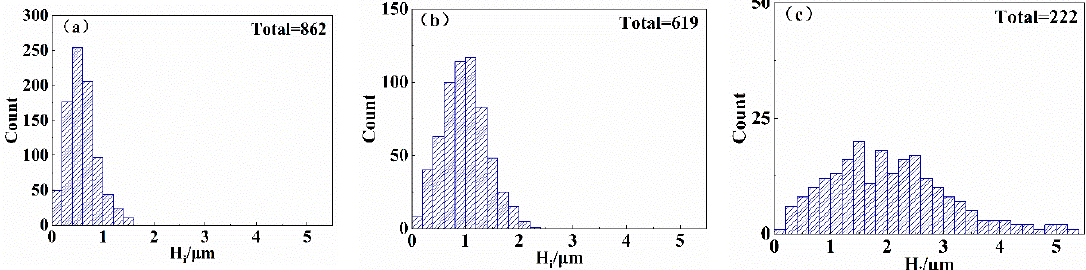
Figure 2. Histogram of height distribution of the three typical pyramidal textures: ( a ) Initial etching, ( b ) moderate etching, ( c ) excessive etching.